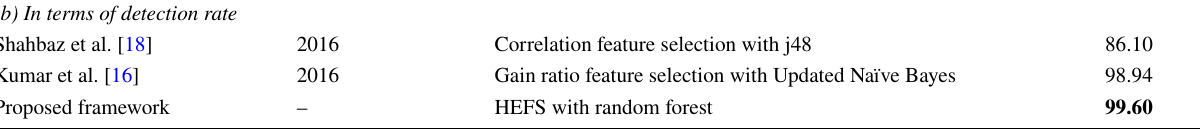
Bold fonts indicate the best results obtained